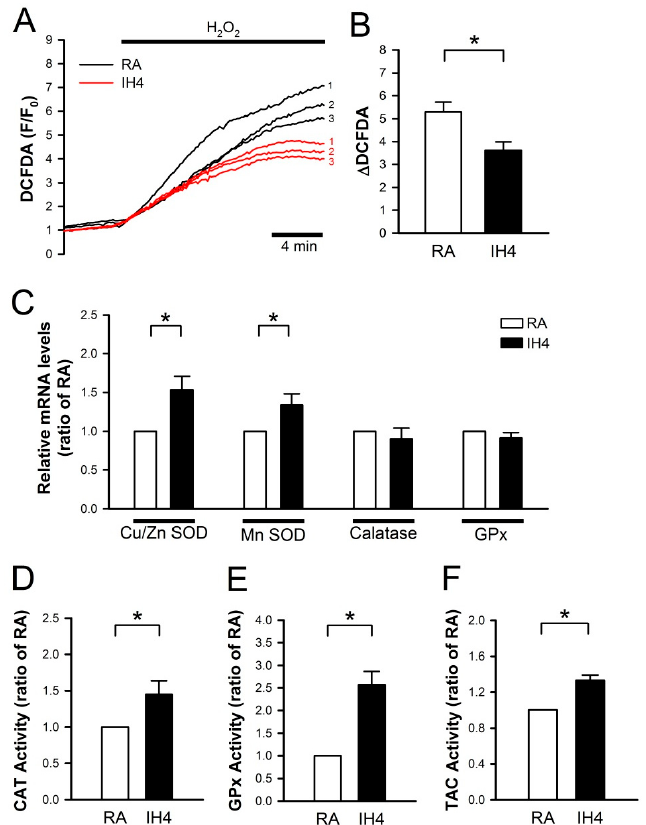
Figure 2. Effects of IH on endogenous antioxidant defense in cardiomyocytes. ( A ) The time course of intracellular ROS changes in cardiomyocytes perfused with H 2 O 2 (30 μ M) was recorded by a real-time fluorescence imaging system. Treatment of cardiomyocytes to IH for four days attenuated the H 2 O 2 -induced increases of intracellular ROS level. ( B ) The difference between baseline and plateau of DCFDA (F/F 0 ) was defined as Δ DCFDA. The quantitative results show that the H 2 O 2 -induced intracellular ROS increase was significantly lower in cardiomyocytes treated with IH4 than with RA. Data represent the means ± SEM. n = 8 for each group, * p < 0.05. ( C ) The levels of Cu/Zn SOD and MnSOD mRNA were significantly higher in the IH4-treated group than the RA-treated group. Data represent the means ± SEM. n = 7 for each group. * p < 0.05. ( D ) The activity levels of catalase (D), GPx ( E ), and TAC ( F ) were significantly higher in the IH4-treated group than in the RA-treated group. (The activities of catalase, GPx and TAC were determined by ELISA. Data represent the means ± SEM. RA: n = 5, IH4: n = 5. * p < 0.05.